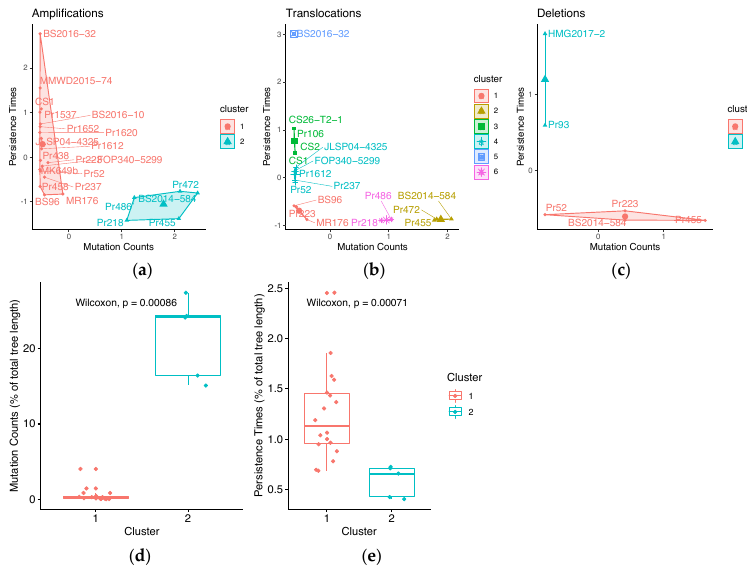
(Figure 5a,c): Cluster 1 represented isolates with a particular genetic background where SVs had high persistence times and low mutation counts; Cluster 2 isolates had SVs with low persistence times and elevated mutation counts. Amplifications had the highest persistence times (2.4 to 11.33% of the phylogeny) of all the SVs and were more frequent in the population (16.38 to 44.08 mutations towards amplified state; Figure S2). Therefore, we assessed the significance of differences in persistence times of amplifications between the two clusters (Figure 5d,e) and found that isolates with higher persistence times and low mutation counts were 16/20 times from common sources, whereas elevated mutation counts and low persistence times were associated with isolates from unusual hosts and host tissue (Table 1). These results suggest that isolates from uncommon sources may have more SVs, but that these mutations do not persist in the population. Isolates from common hosts have relatively few SVs, but these mutations are transmitted to extant lineages.